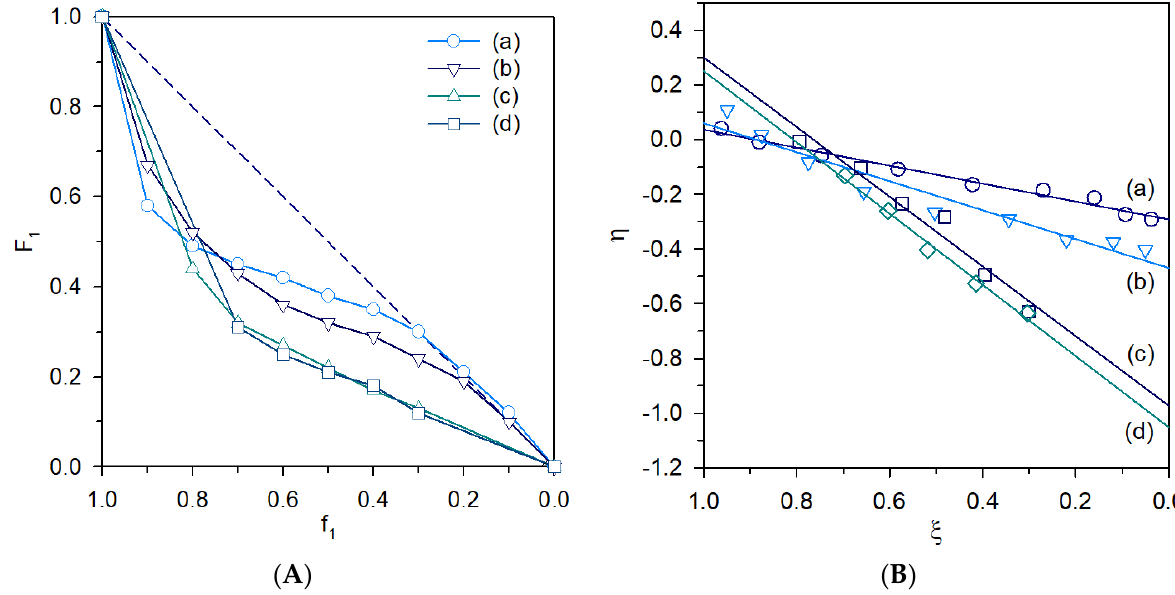
Figure 2. ( A ) Dependence of the copolymer composition, F 1 , on the initial comonomer feed composition, f 1 , and ( B ) Kelen– Tüdos plots for the determination of the reactivity ratios for (a) Bn-Glu NCA and Ala NCA, (b) Bn-Cys NCA and Ala NCA, (c) Bn-Ser NCA and Ala NCA, and (d) Phe NCA and Ala NCA copolymerization systems, where Ala NCA is monomer 2 in all cases.